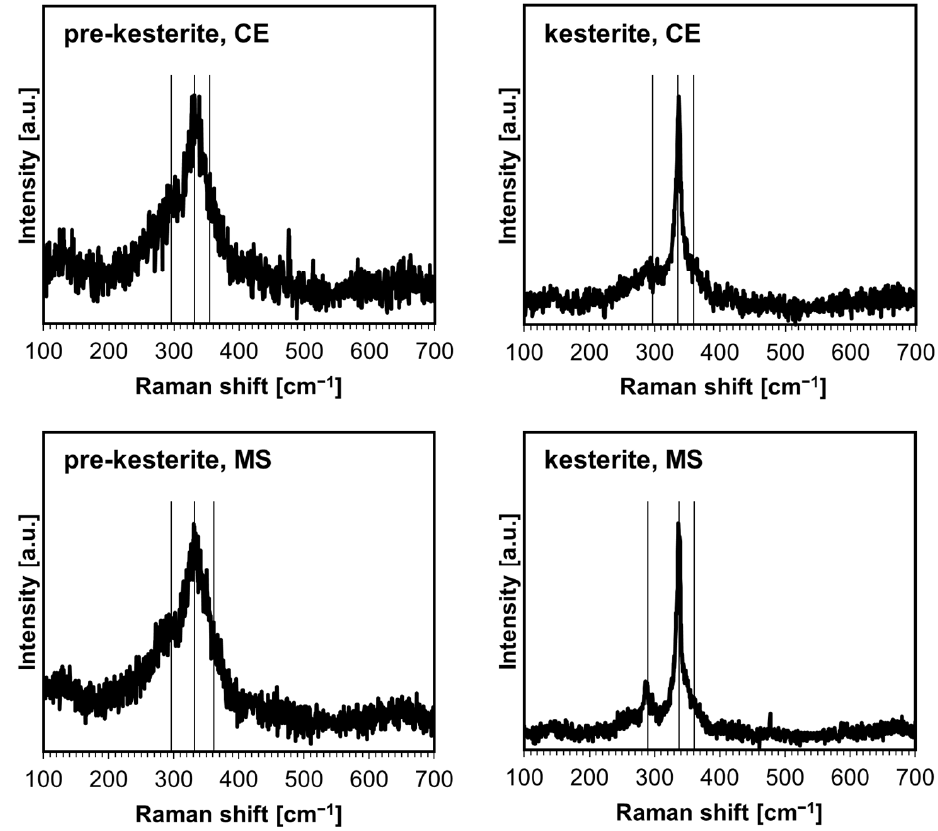
Figure 3. Raman spectra for the nanopowders from the CE system ( top row) and MS system ( bottom row). Vertical lines indicate the approximate positions of kesterite-specific Raman bands.